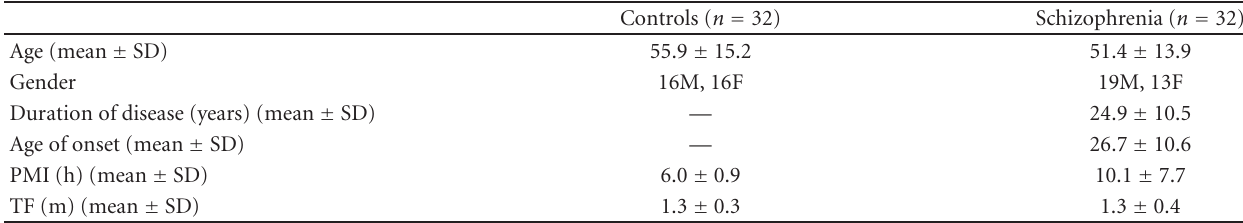
Table 2: Demographic data of MHRC brain collection.